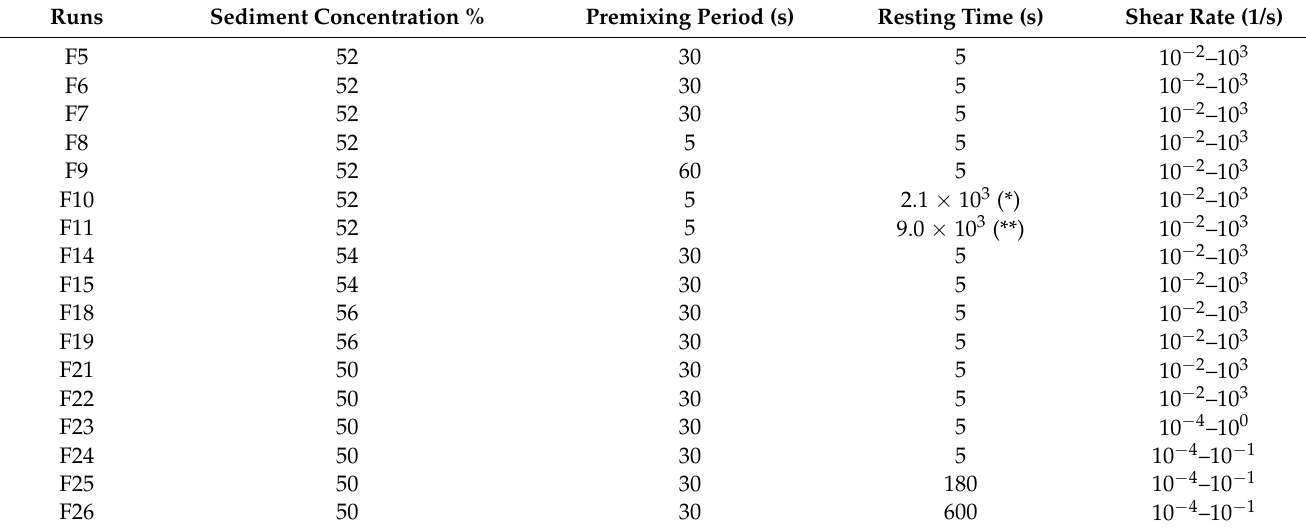
Table 1. Sweep tests summary.